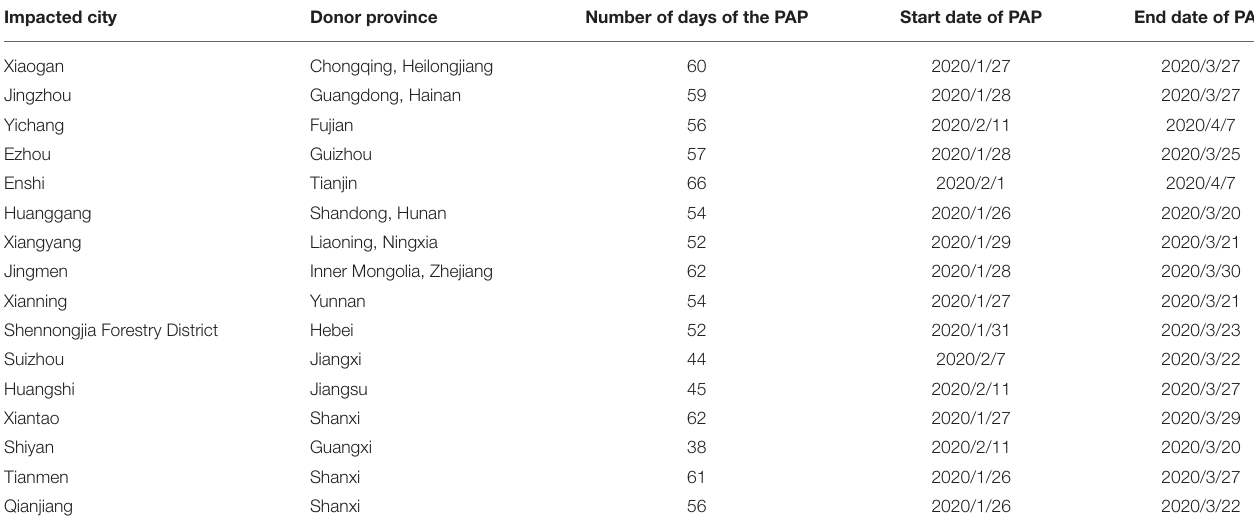
TABLE 1 | Detailed aid situation in 16 cities in Hubei Province. Impacted